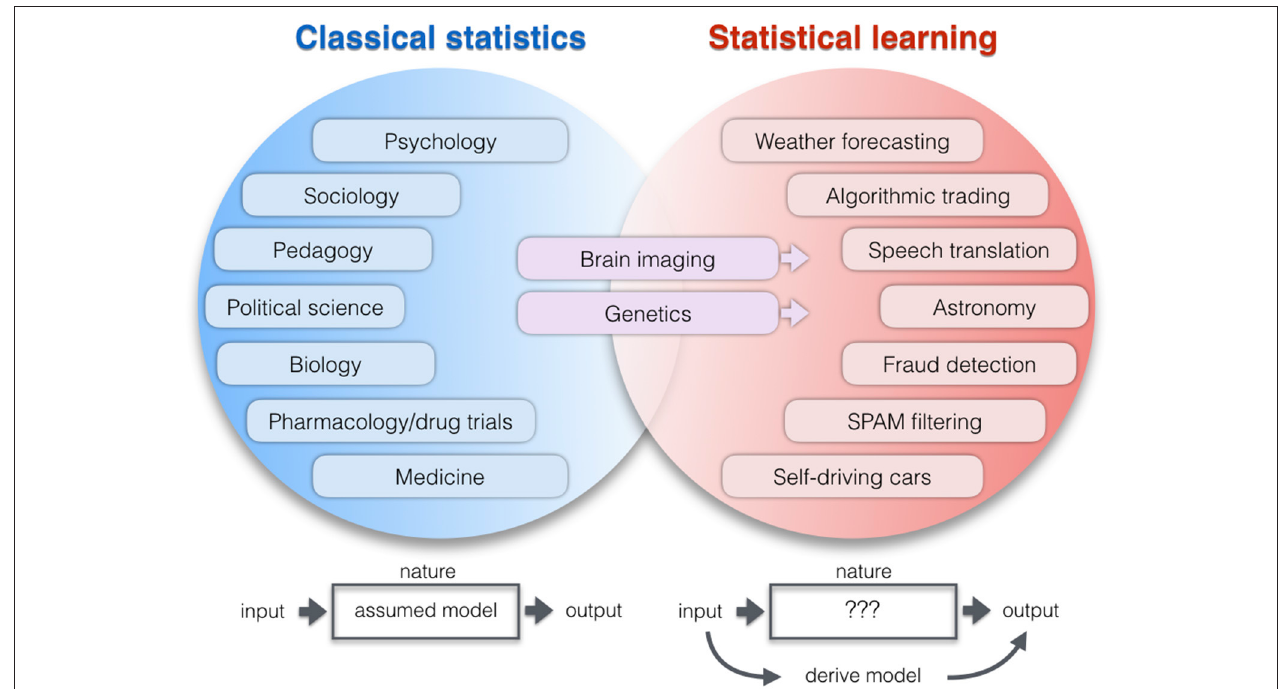
FIGURE 1 | Application areas of two statistical paradigms. Lists examples of research domains which apply relatively more classical statistics (blue) or learning algorithms (red). The co-occurrence of increased computational resources, growing data repositories, and improving pattern-learning techniques have initiated a shift toward less hypothesis-driven and more algorithmic methodologies. As a broad intuition, researchers in the empirical sciences on the left tend to use statistics to evaluate a pre-assumed model on the data. Researchers in the application domains on the right tend to derive a model directly from the data: A new function with potentially many parameters is created that can predict the output from the input alone without explicit programming model. One of the key differences becomes apparent when thinking of the neurobiological phenomenon under study as a black box ( Breiman, 2001). ClSt typically aims at modeling the black box by making a set of formal assumptions about its content, such as the nature of the signal distribution. Gaussian distributional assumptions have been very useful in many instances to enhance mathematical convenience and, hence, computational tractability. Instead, StLe takes a brute-force approach to model the output of the black box (e.g., tell healthy and schizophrenic people apart) from its input (e.g., volumetric brain measurements) while making a possible minimum of assumptions (Abu-Mostafa et al., 2012). In ClSt the stochastic processes that generated the data is therefore treated as partly known, whereas in StLe the phenomenon is treated as complex, largely unknown, and partly